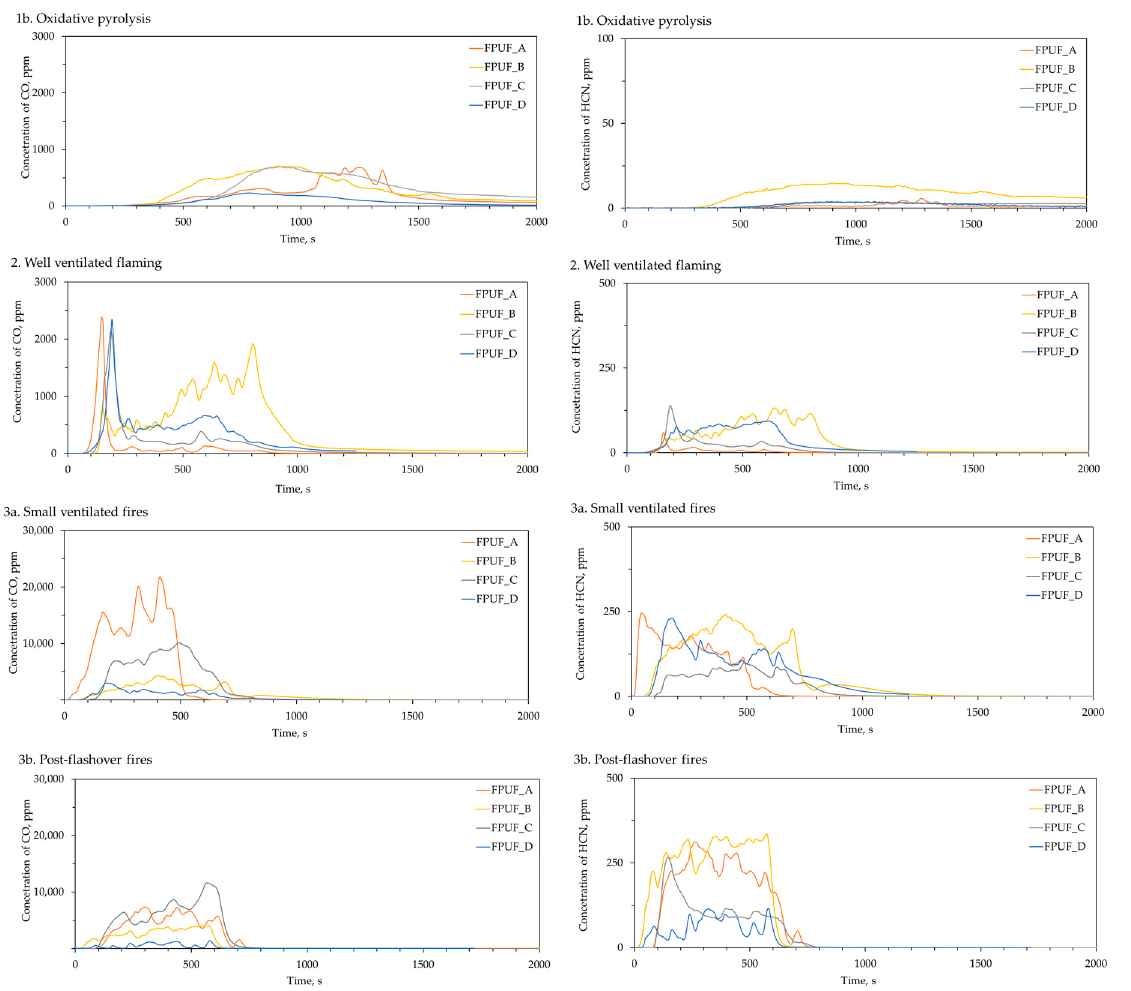
Figure 3. Yields of carbon monoxide (CO) and hydrogen cyanide (HCN) released during thermal degradation and combustion of flexible polyurethane foams in conditions presented in Table 4.